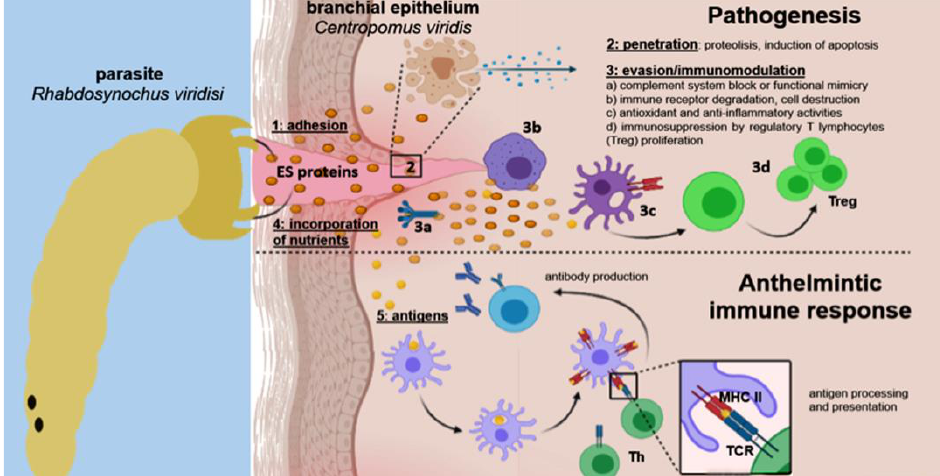
Figure 4. Excretory/secretory (ES) proteins from Rhabdosynochus viridisi could be involved in (1) adhesion, (2) penetration and destruction of branchial epithelium, (3) immune evasion strategies (in monocytes 3b, dendritic cells 3c, and T lymphocytes 3d), (4) nutrition, and (5) immunogenicity (the antigens are taken by Antigen Presenting Cells and then presented to T helper